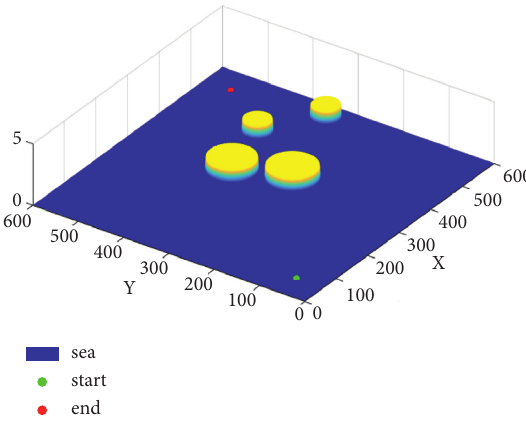
Figure 7: Experimental